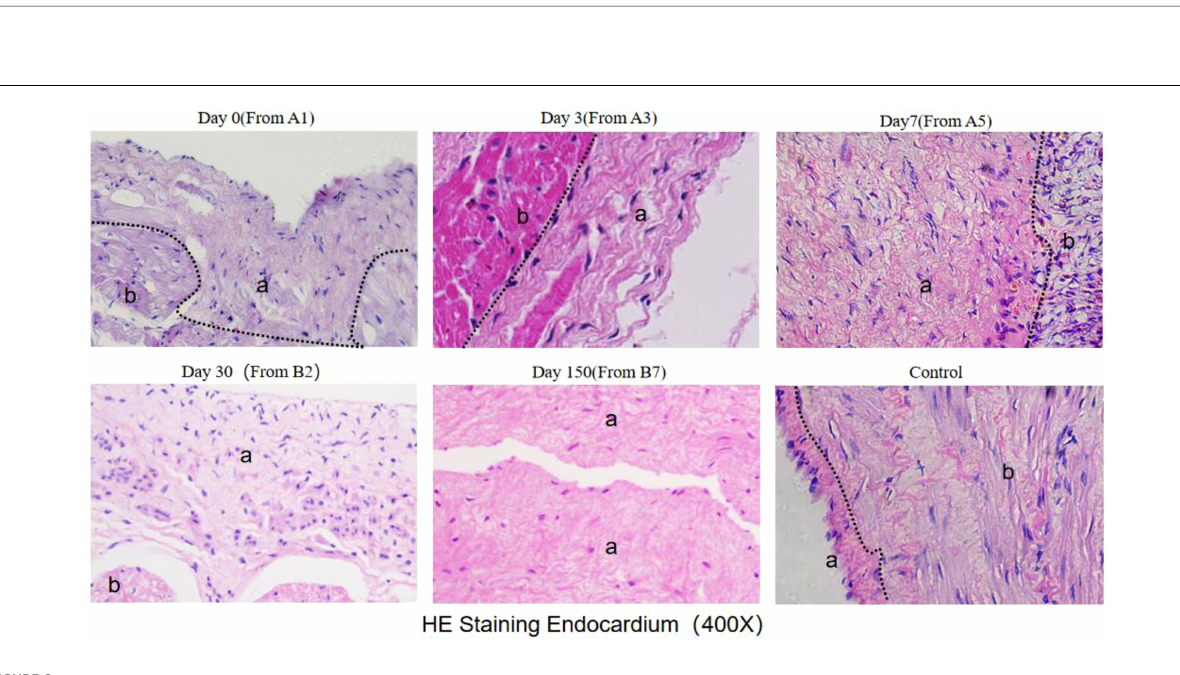
The results of TUNEL staining showed that after ablation, a minimal amount of localized apoptosis appeared in the Day0 group within the fi rst two hours. In contrast, a signi fi cant concentration of apoptosis was observed in the Day3 group.